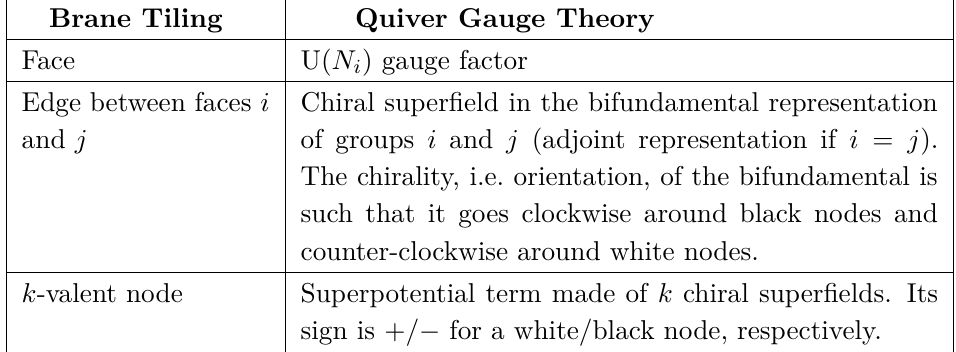
Table 1. Dictionary relating brane tilings to quiver gauge theories.